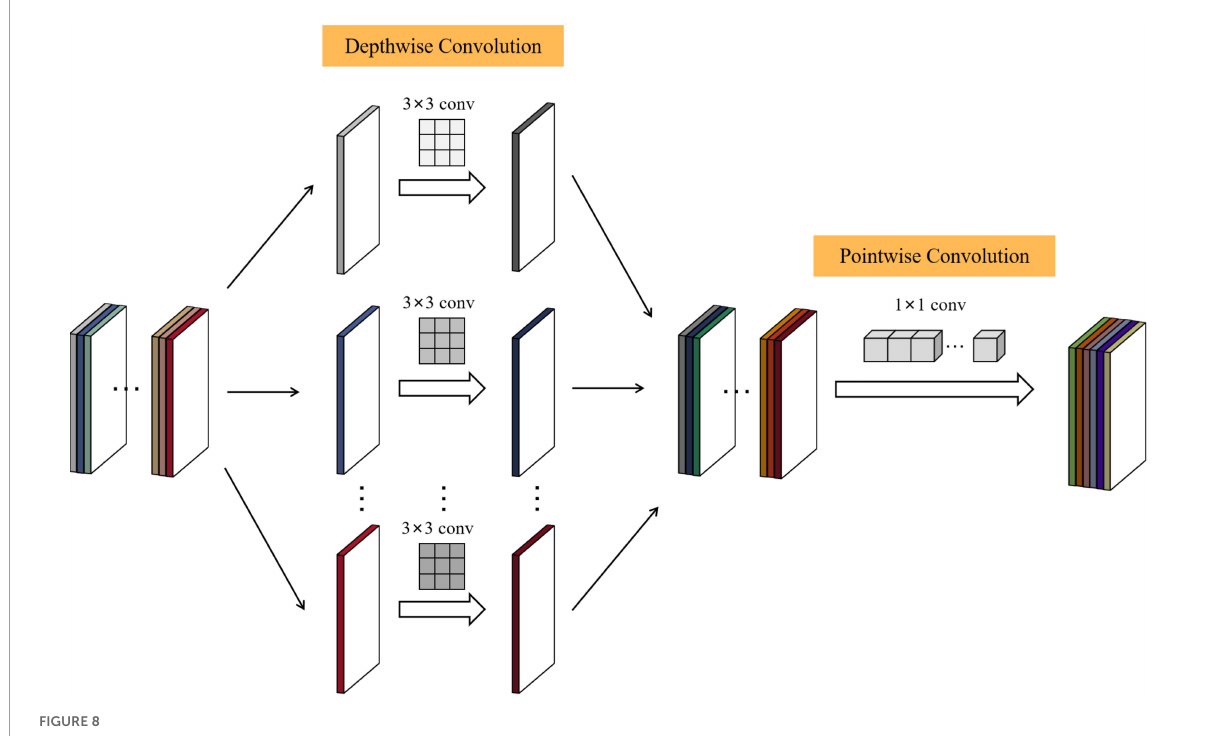
FIGURE8 Working principle of depthwise separable